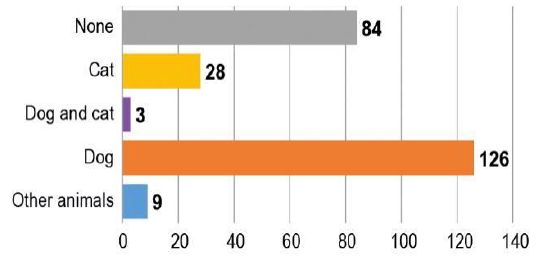
Figure 4. Pet owned by respondents who consider CODs an effective measure to control stray dog populations ( n = 250).